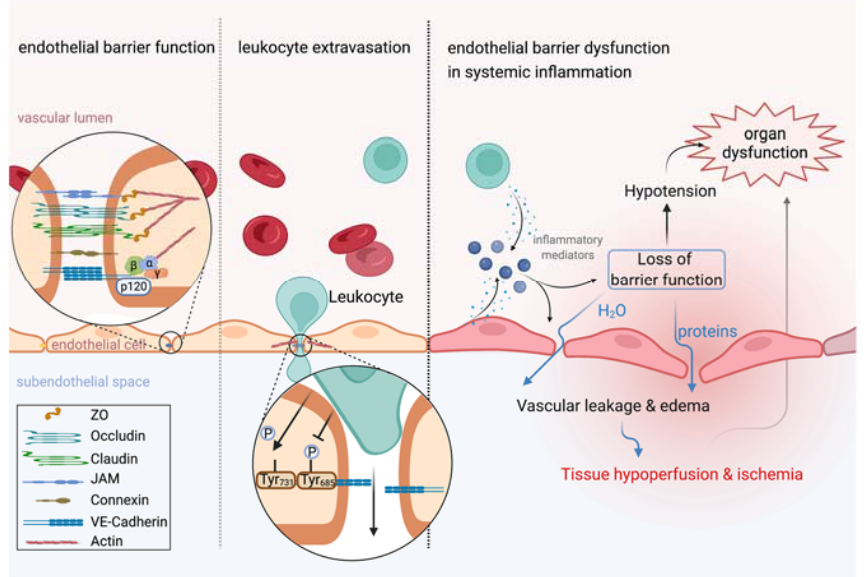
Figure 1. Leukocyte extravasation is independent from vascular leakage. Left: Endothelial barrier function is tightly controlled by intercellular junctions including adherens junctions and tight junctions that connect neighboring endothelial cells. Middle: Leukocyte extravasation is accelerated by dephosphorylation of VE-cadherin at tyrosine residue 371, whereas inflammatory stimuli induce vascular leakage by phosphorylation at tyrosine residue 685. Actin dynamics further contribute to keeping vascular leakage during leukocyte extravasation to a minimum. Right: Inflammation induces rapid release of inflammatory mediators by several cell types, such as endothelial cells or leukocytes. Endothelial cell activation upon inflammatory stimuli, such as VEGF or histamine, induces vascular leakage leading to translocation of protein-rich plasma into the extravascular space. If the inflammatory response becomes systemic, a ubiquitous loss of endothelial barrier function promotes tissue edema formation and hypotension that severely impair perfusion and oxygen supply to tissues and is thus identified as a key contributor to organ dysfunction. This figure was created with BioRender.com.